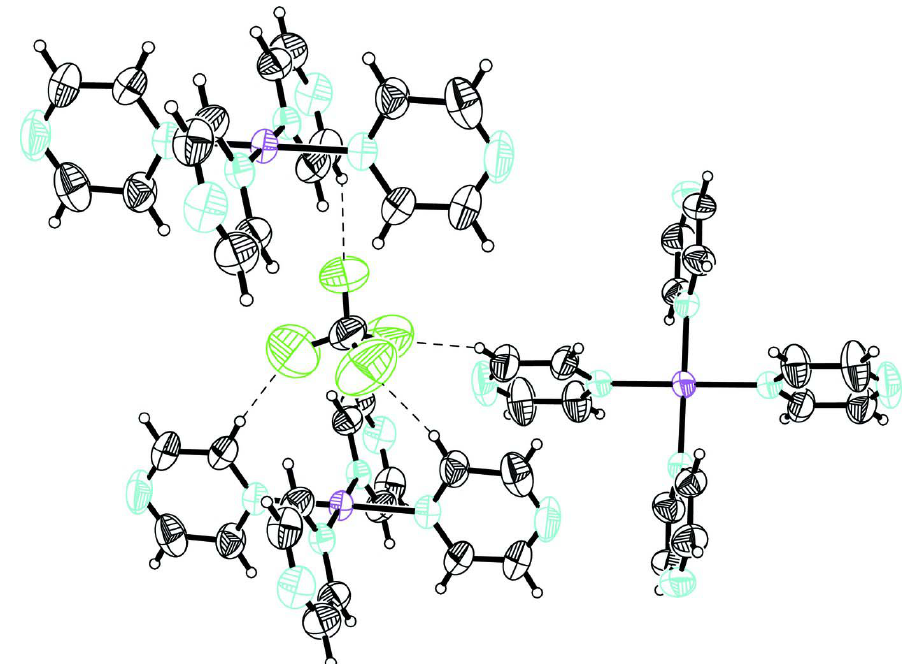
View of the hydrogen bonding between the tetrafluoroborate anion and the tetrapyrazineplatinum(II) cation (50% probability displacement